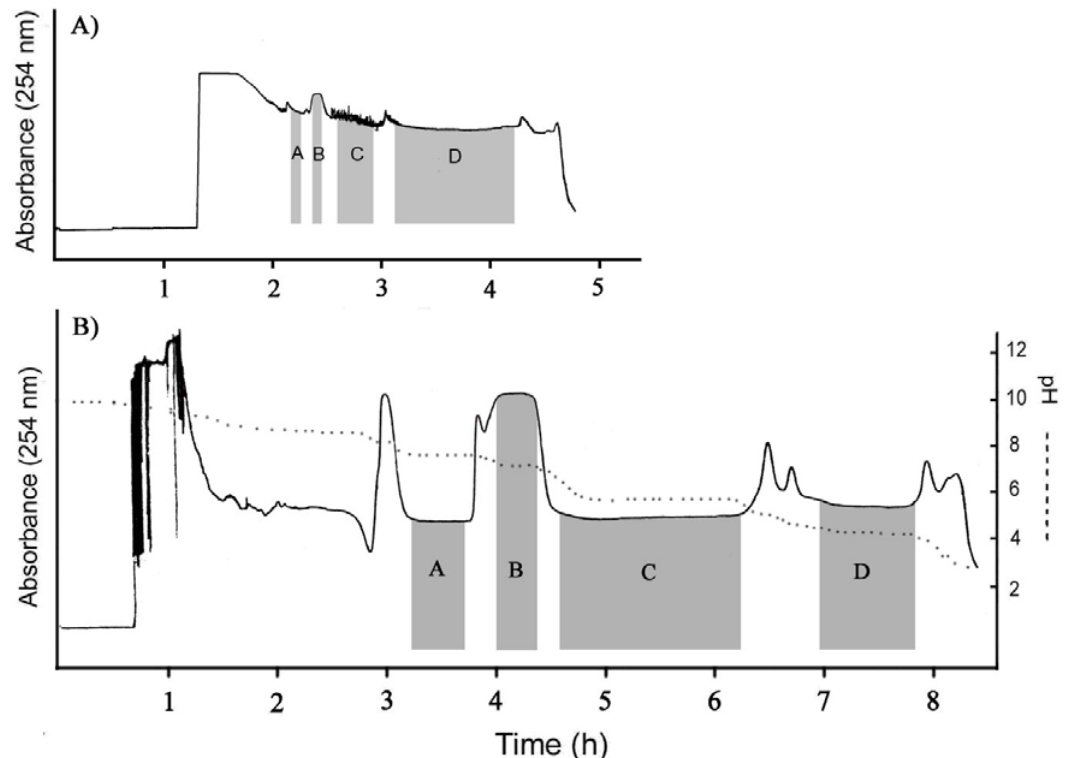
Figure 1. pH-Zone-refining CCC chromatograms of crude alkaloids extracts from Corydalis bungeana . ( A ) Two-phase solvent system: Pet–EtAc–MeOH–H 10 m M TEA in the upper phase and 5 m M HCl in the lower phase; flow rate: 1.5 mL/min; detection wavelength: 254 nm; revolution speed: 800 rpm; sample size: 3.0 g. The retention of the final stationary phase: 38%; ( B ) Two-phase solvent system: Pet–EtAc–MeOH–H (5:5:2:8, v/v), 10 m M TEA in stationary phase and 5 m M HCl in lower phase; flow rate: 1.5 mL/min; detection wavelength: 254 nm; revolution speed: 800 rpm; sample size: 3.0 g; The retention of the final stationary phase: